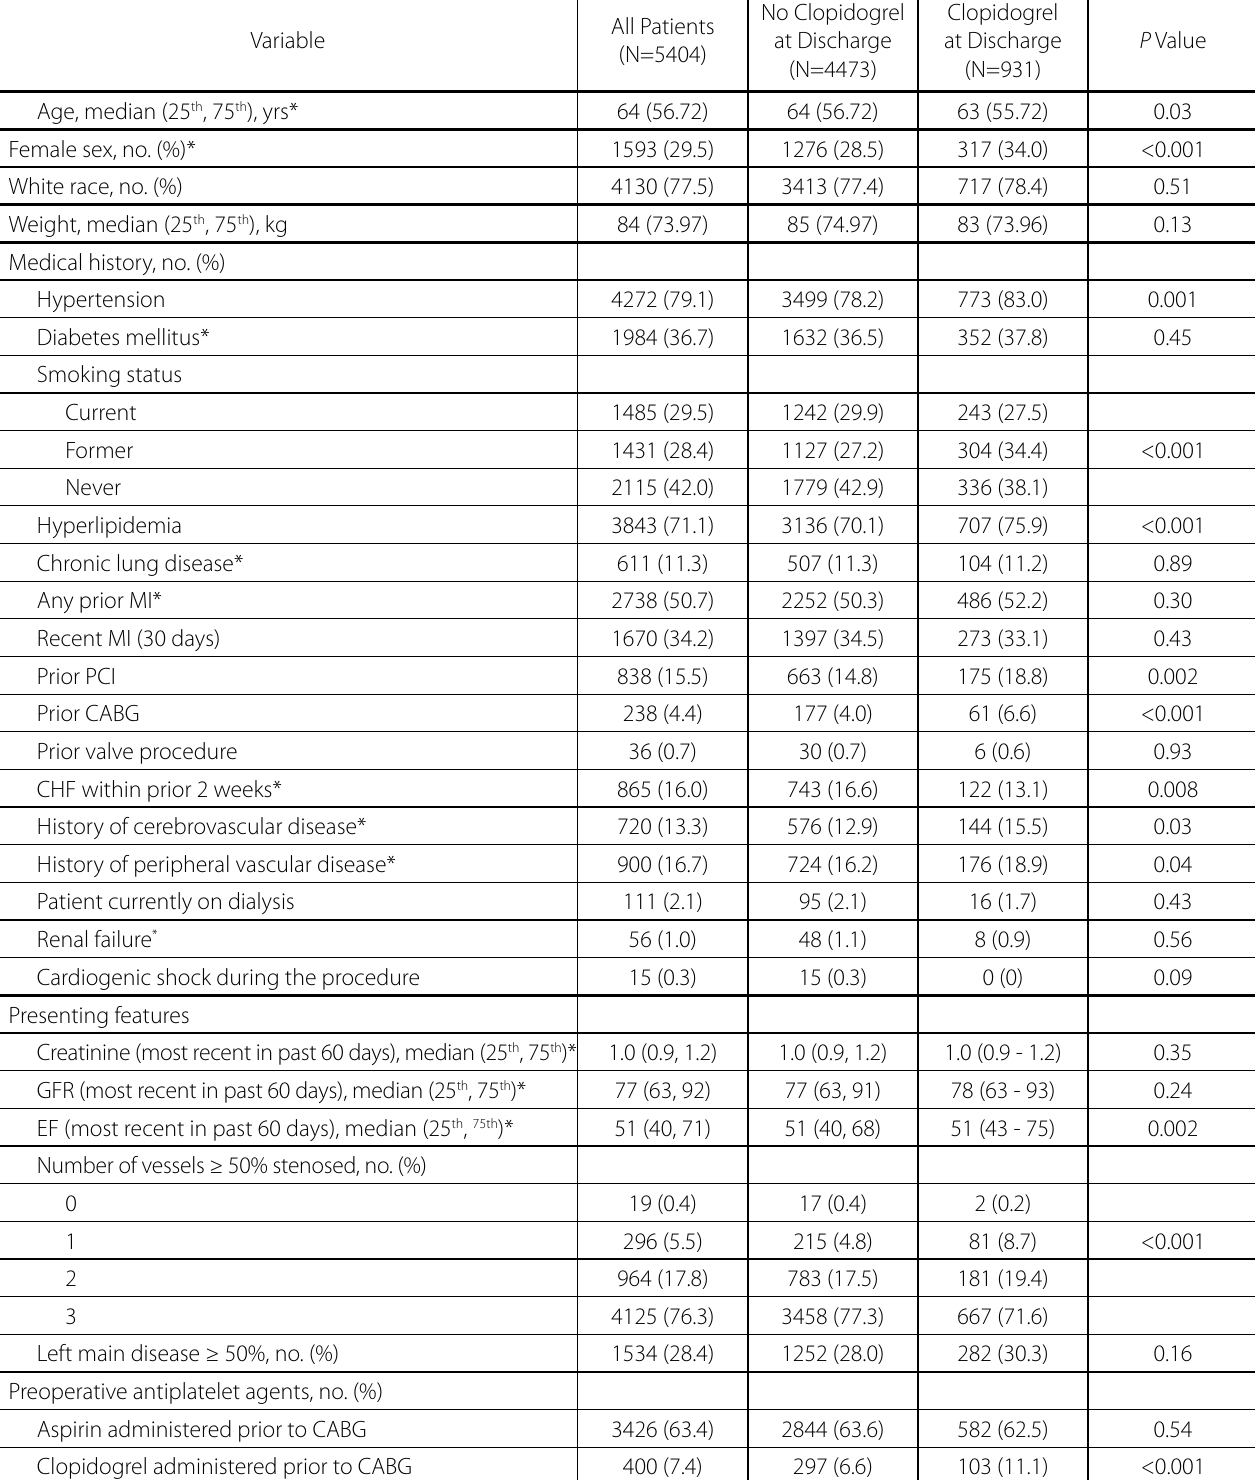
Table 1. Baseline characteristics according to clopidogrel use after